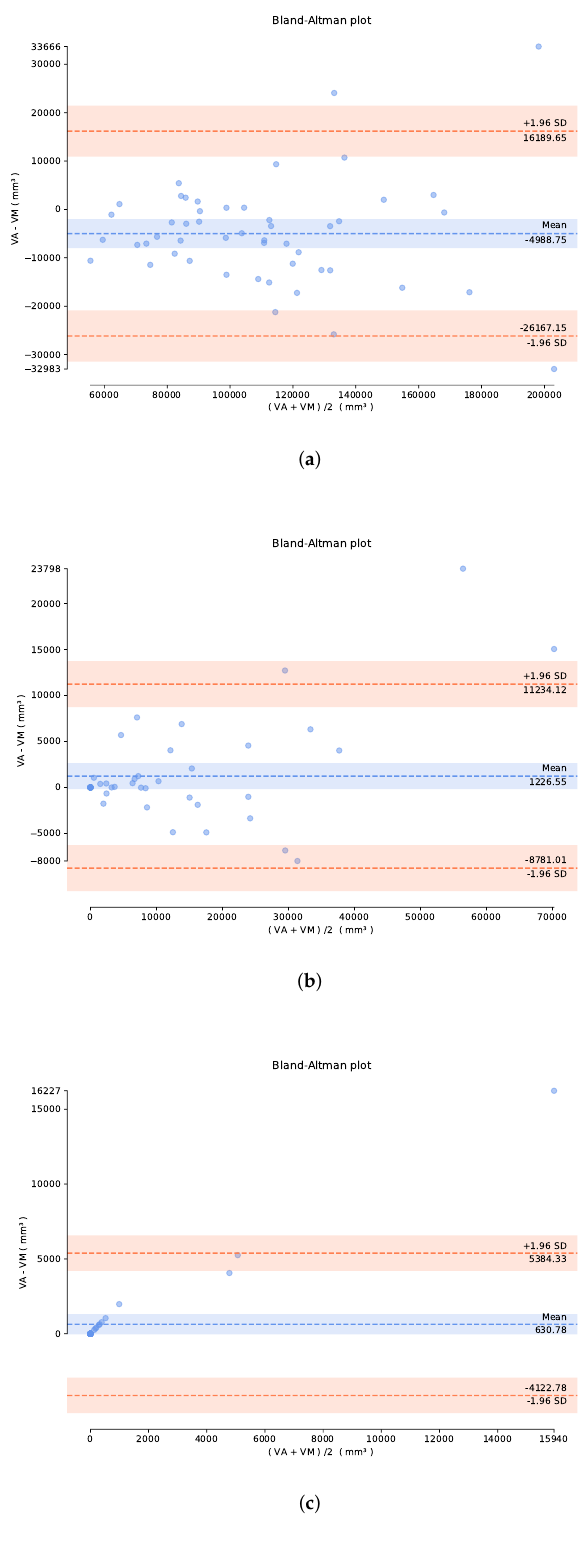
Figure 8. The graph represents the difference between the generated method and the expert target volumes according to their average. ( a ) Bland–Altman plot of LV myocardium volume acquired from our ICPIU-Net approach. ( b ) Bland–Altman plot of infarct volume acquired from our ICPIU-Net approach. ( c ) Bland–Altman plot of MVO volume acquired from our ICPIU-Net